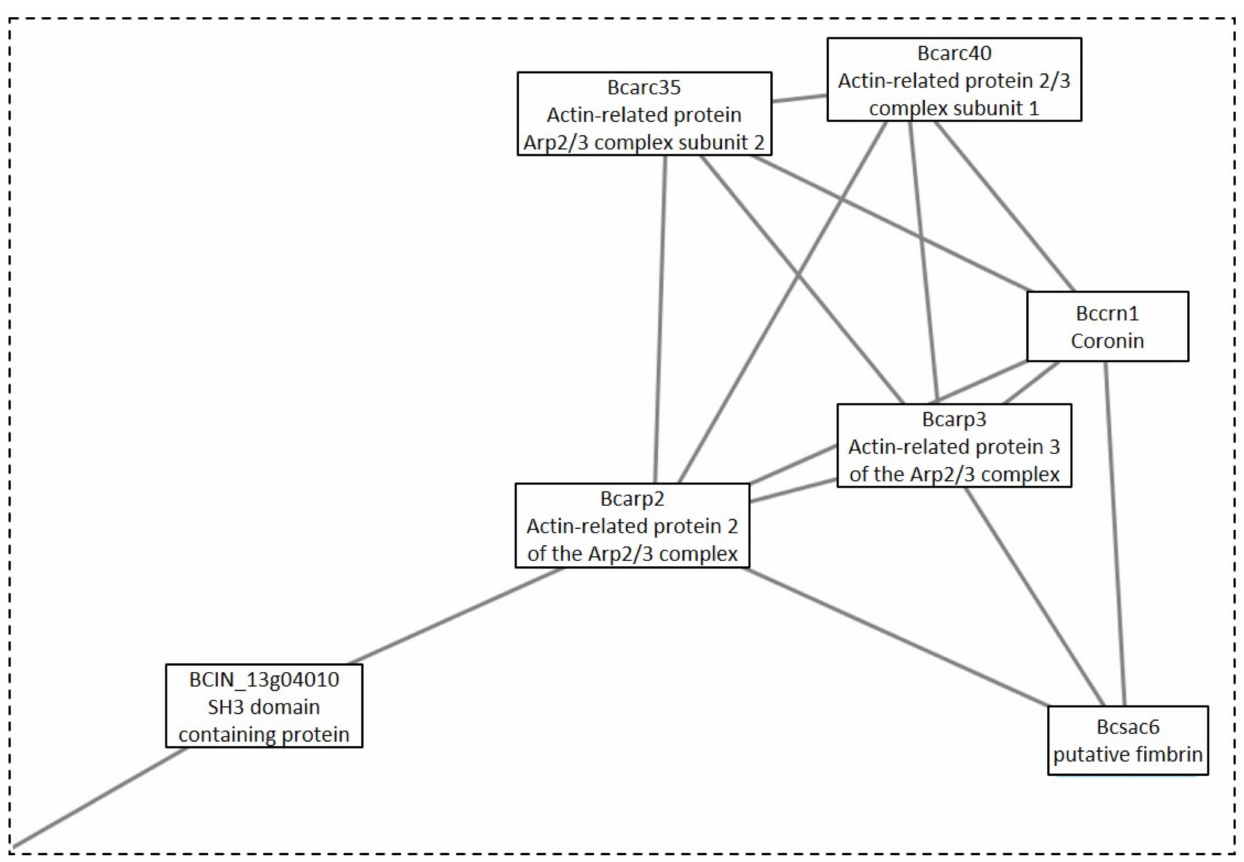
Figure 8. Section A from Cluster 10 (Figure